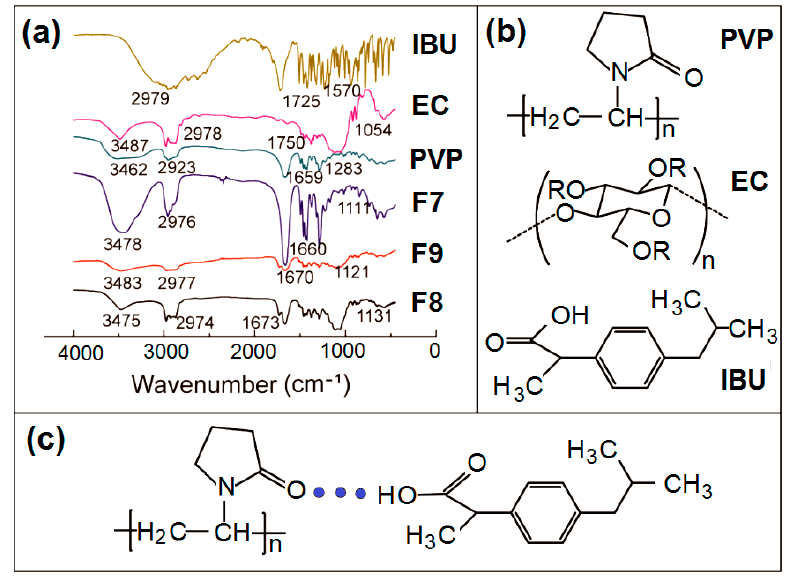
Figure 7. Compatibility studies: ( a ) FTIR spectra of PVP, EC, IBU and their products F7, F8, and F9. ( b ) The molecular formula of the raw materials; and ( c ) the hydrogen bonding between IBU and PVP molecules.